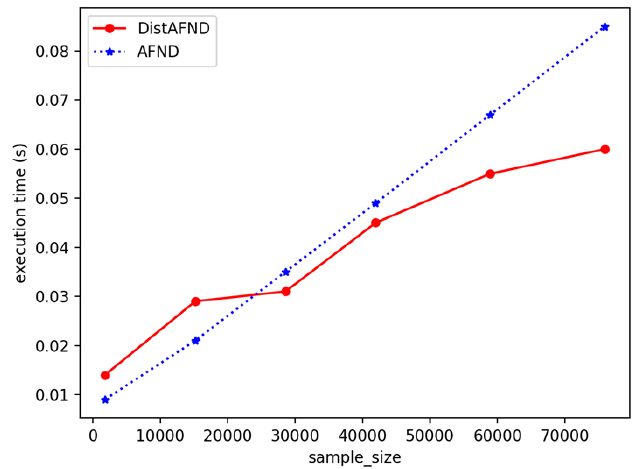
Figure 5. Execution time by sample